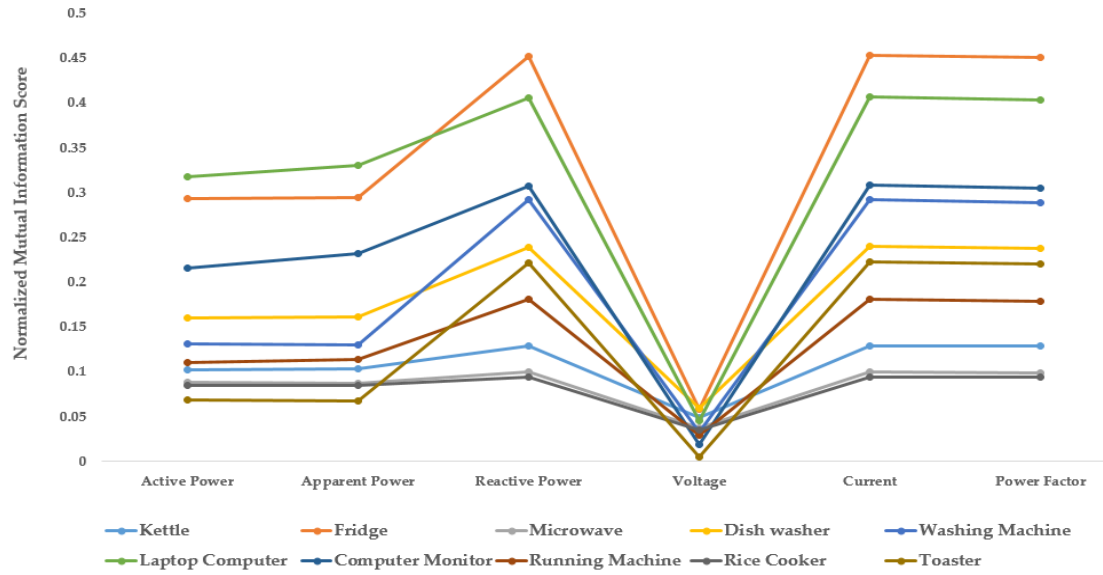
Figure 5. Normalized mutual information scores between various electrical features and target appliance power consumption.